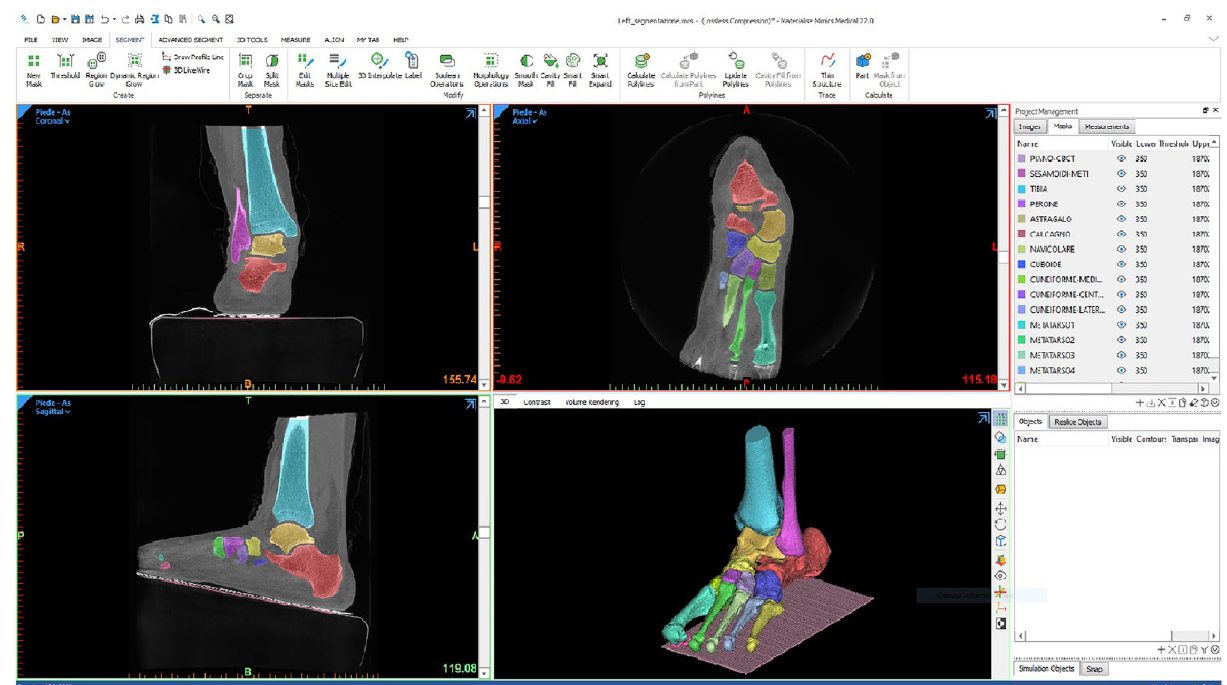
Figure 1. A screenshot from the 3D reconstruction of the foot bones from a CBCT scan by Mimics Innovation Suite (Materialise, Belgium) software. Each bone segment has a different colour, in both the 3D view (bottom- right) and in the three anatomical planar views; in this antero-posterior slice (top-left), the tibia, fibula, calcaneus and talus bone segments are depicted. In the sagittal view (bottom-left), apparently the foot is